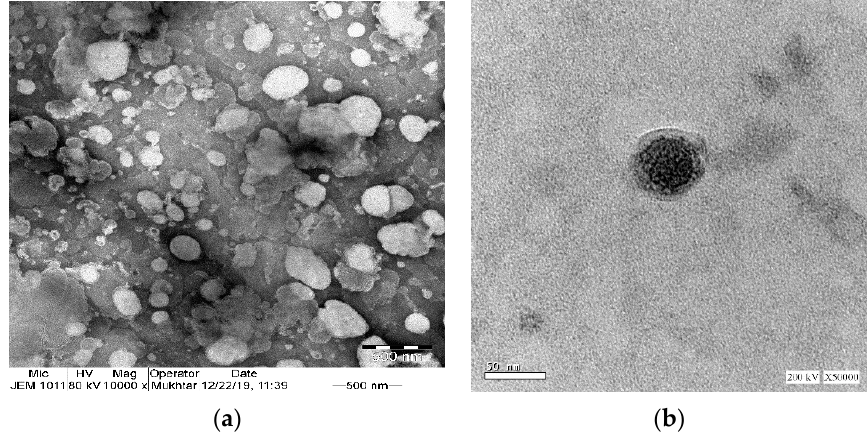
Figure 4. Transmission electron microscope images of ( a ) optimized ICA-phytosomes (×10,000) and ( b ) placebo-phytosomes (×50,000).